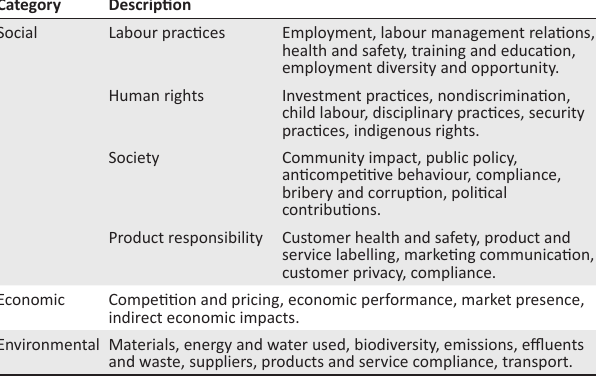
TABLE 1: Abridged global reporting initiative performance